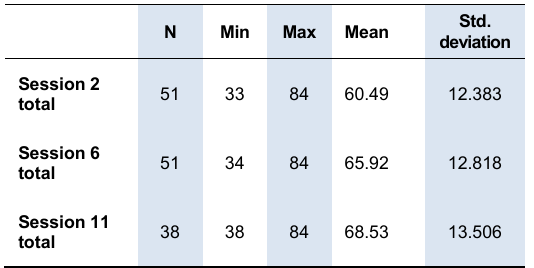
Table 6: Working Alliance Inventory descriptive